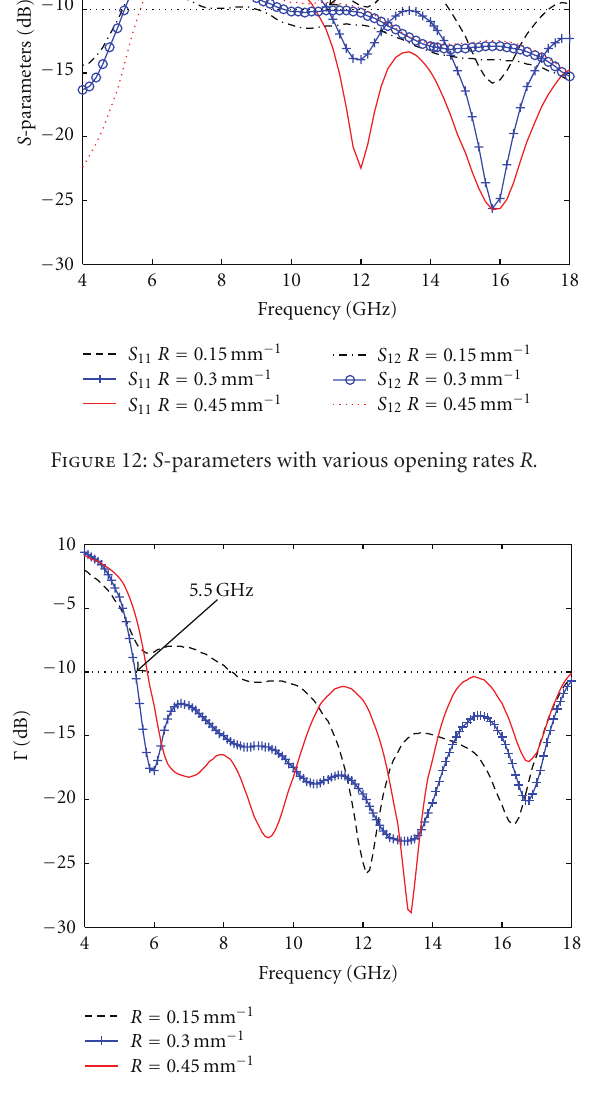
Figure 13: The active reflection coe ffi cient Γ with various opening rates R